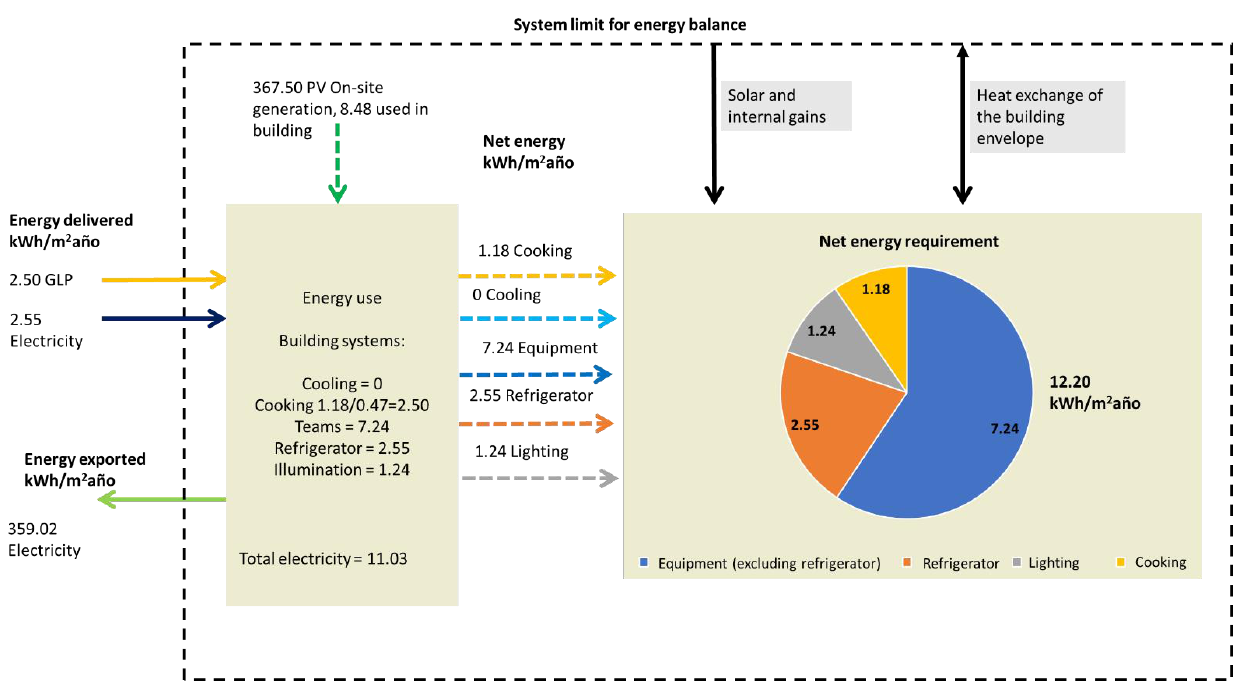
Figure 16. System limit for energy balance (in terms of primary energy), adapted from [40].